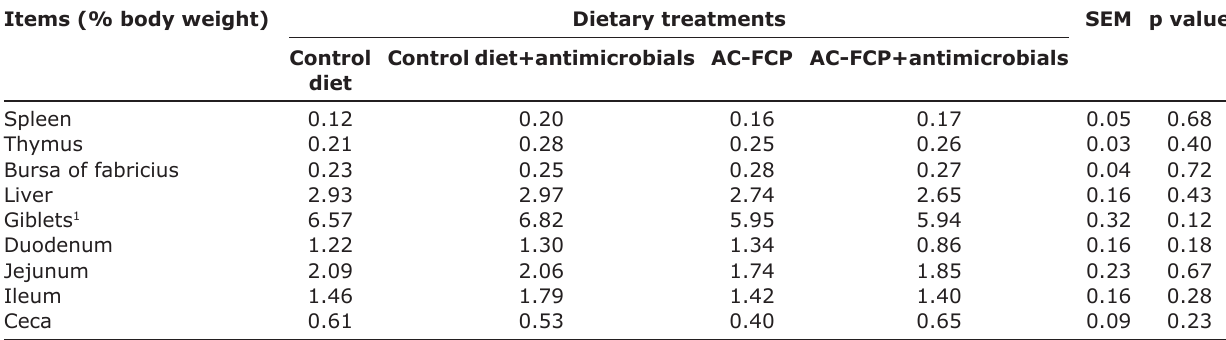
Table-5: Internal organ weight of broilers fed the treatment diets. Items (% body